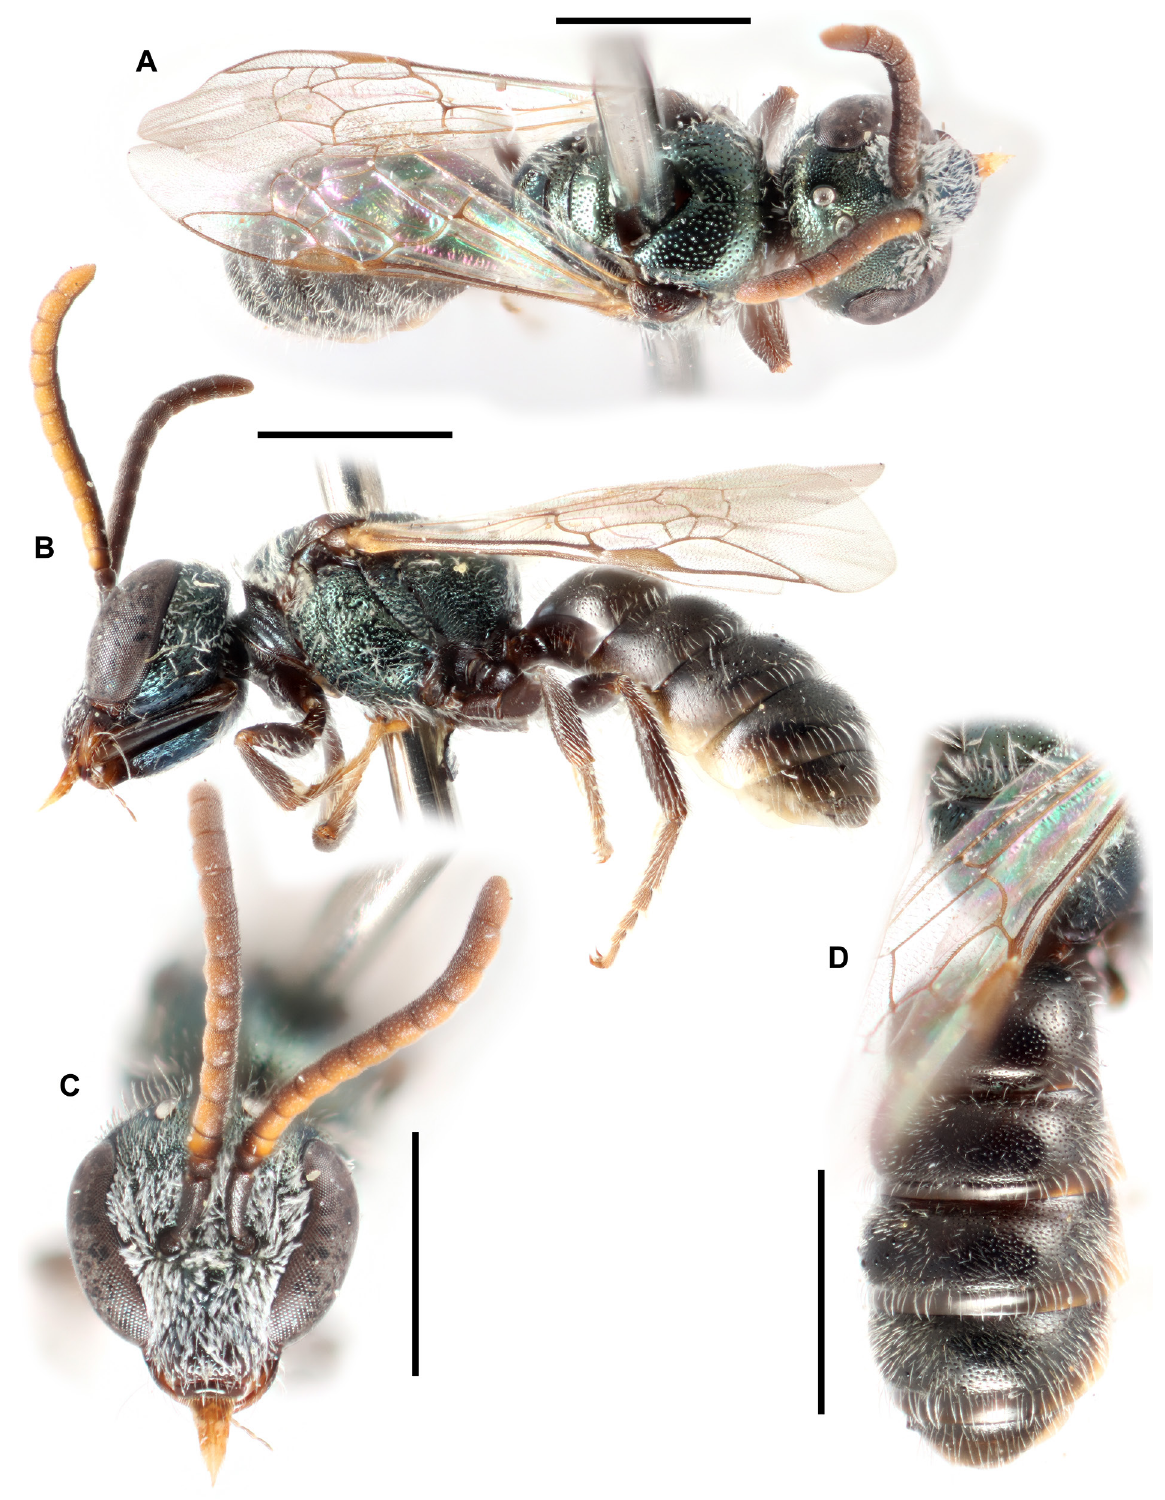
Fig. 10. Lasioglossum ( D .) coactus (Cresson, 1872), ♂. A . Dorsal habitus. B . Lateral habitus. C . Face. D . Metasoma. Scale bars = 1